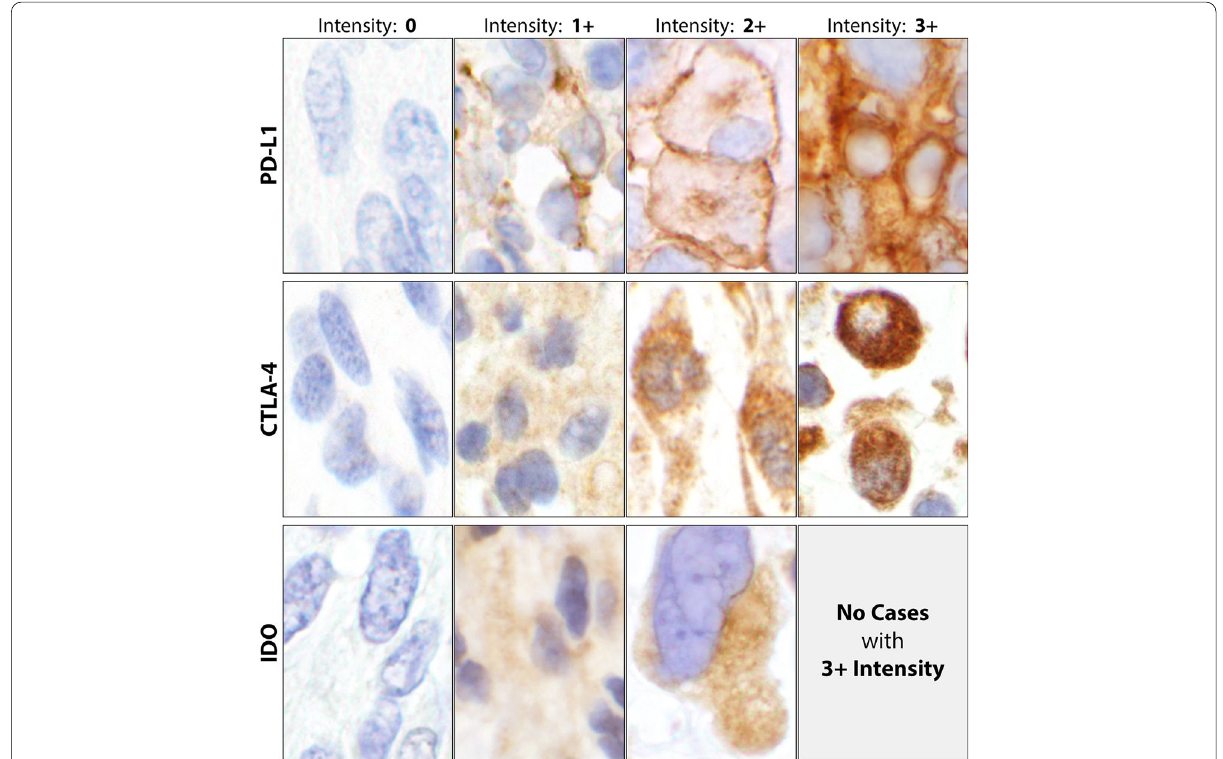
Fig. 2 Immunohistochemical (IHC) reactions’ intensities. Intensity 0, showing no cell membrane staining for PD-L1 and no cytoplasmic reactions for CTLA-4 and IDO. Intensity 1 , showing a weak partial cell membrane staining for PD-L1 and a low number of reactive cytoplasmic granules for + CTLA-4 and IDO. Intensity 2 , the cell membrane staining is more intense and completely circumferential for PD-L1. The IHC reactions depicted + a moderate number of reactive cytoplasmic granules for CTLA-4 and IDO. Intensity 3 , showing a very intense and completely circumferential + membrane staining for PD-L1 and a high number of reactive granules packed in the cytoplasm for CTLA-4. Since no 3 intensity for IDO was + encountered in this study, no photograph was included. Generally, the IDO reactions were rather defuse and less granular than CTLA-4. Since no tumor cell staining was noticed, PD-1 was excluded in this Fig. (60 objective). Abbreviations: PD-L1, programmed death-ligand 1; CTLA-4, × cytotoxic T lymphocyte antigen 4; IDO, indolaimine-2,